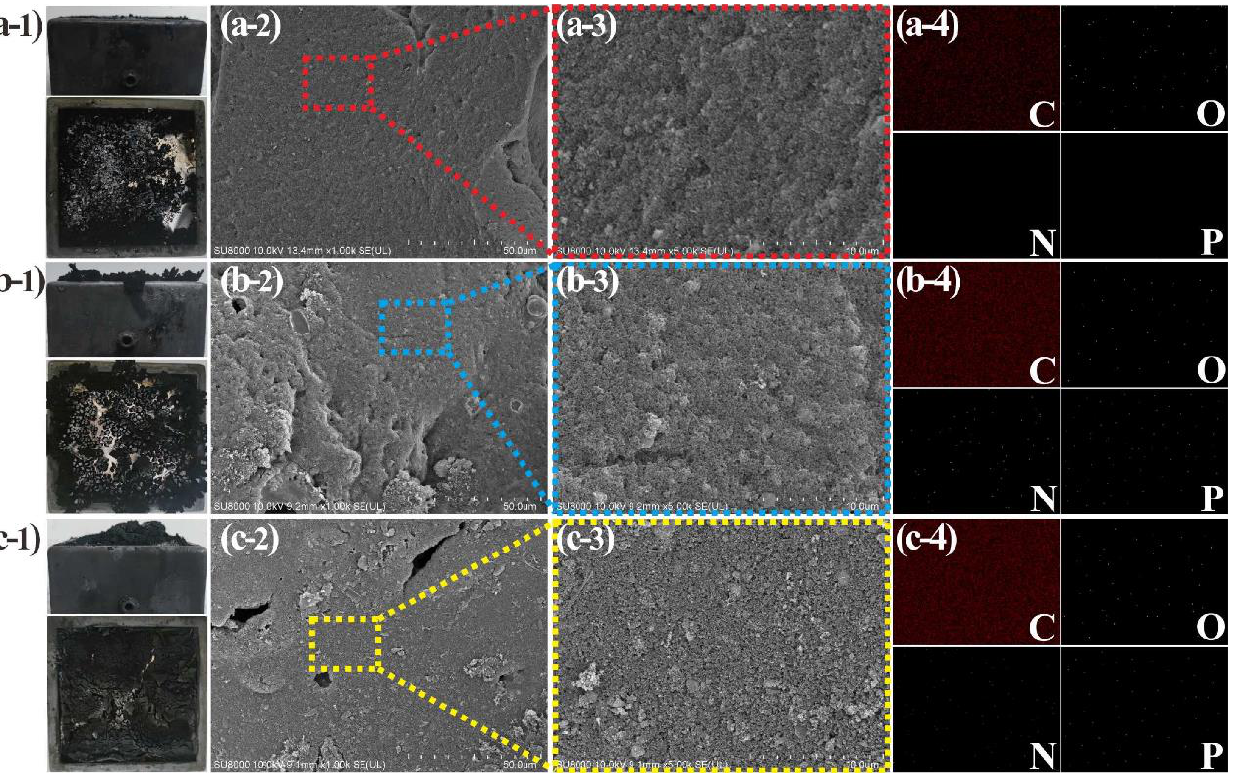
Figure 5. Char residue analysis of NR0 – NR2 composites after CCT: digital photos ( a-1 , b-1 , c-1 ); SEM images ( a-2 , b-2 , c-2 , a-3 , b-3 , c-3 ); EDS-mapping spectrum after 15 min of scanning ( a-4 , b-4 , c-4 ).